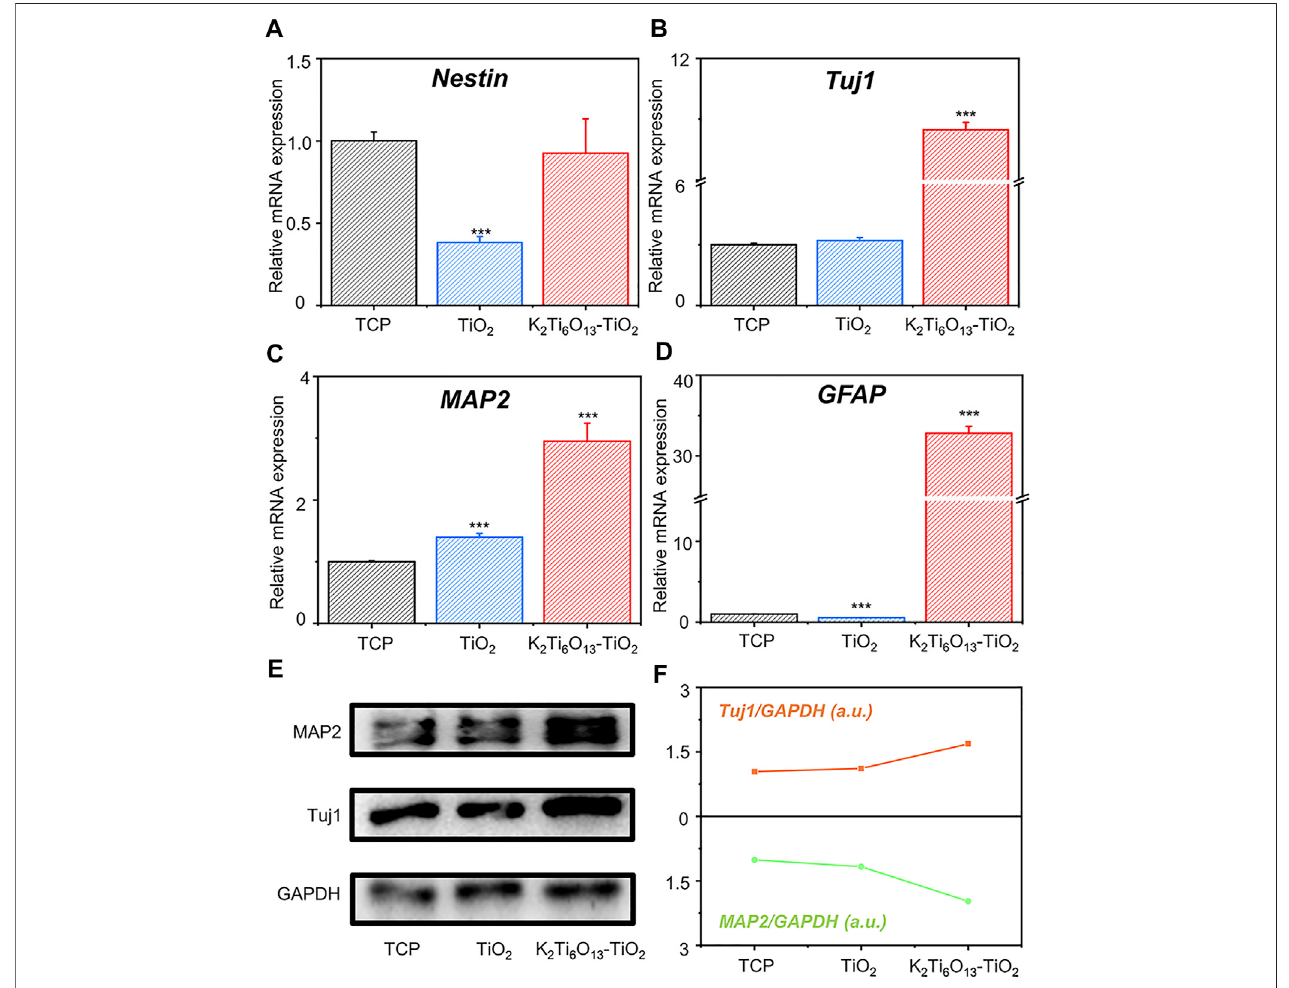
FIGURE 5 | Gene and protein expression of the neural differentiation of NSCs on TiO 2 nanotube and K 2 Ti 6 O 13 -TiO 2 hybrid nanorod arrays for 7 days. Relative mRNA expression of (A) Stemness gene Nestin, (B) Neuromarker Tuj1, (C) Neuromarker MAP2, and (D) Glial cells marker GFAP. (E) Western blot image and (F) quantitative analysis of neural markers Tuj1 and MAP2. Data represent the mean ± standard deviation ( n = 3). *** p < .001 compared with TCP.